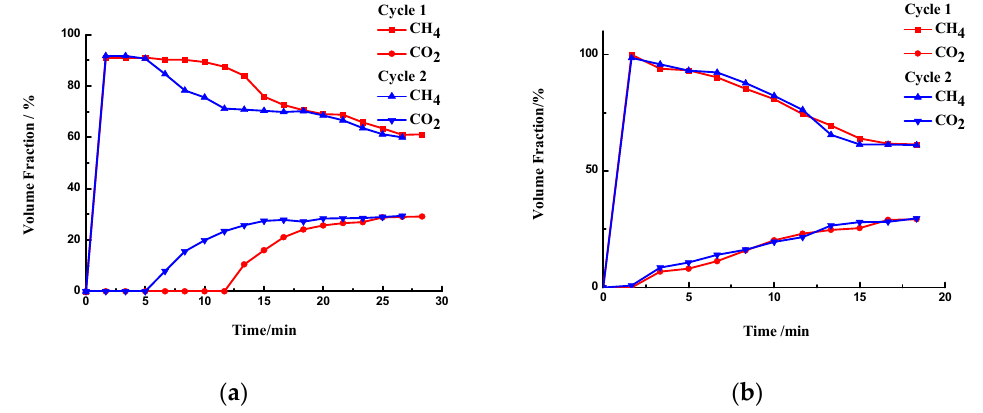
Figure 7. Adsorption / desorption cycles: ( a ) 13X zeolite; ( b ) CMS.